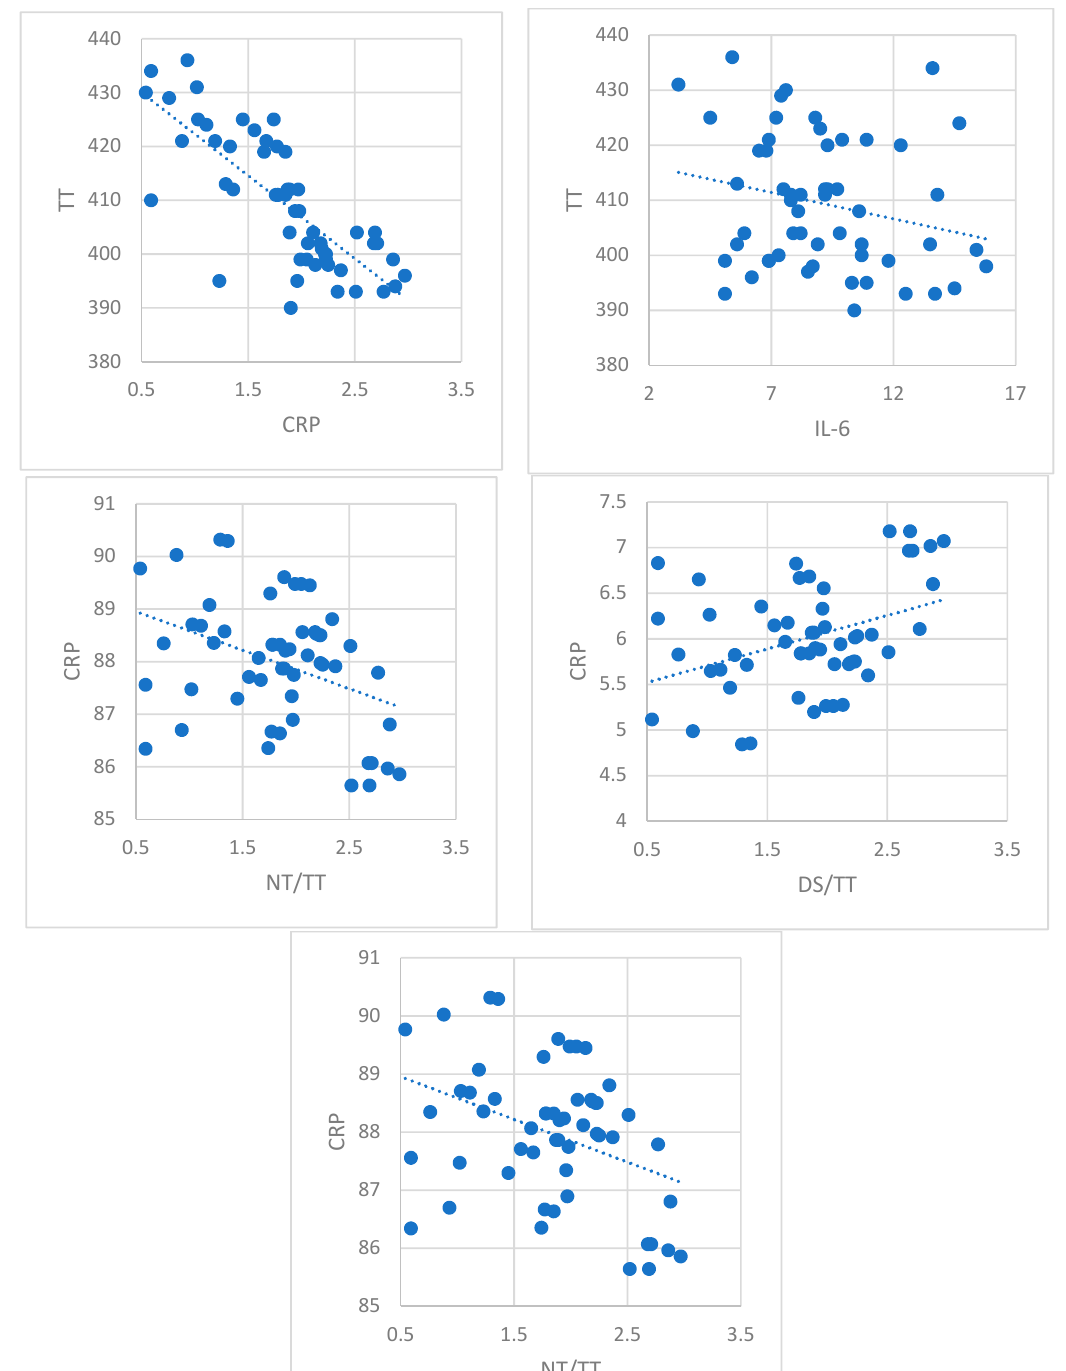
Figure A5. Thiol/Disulfides and CRP and